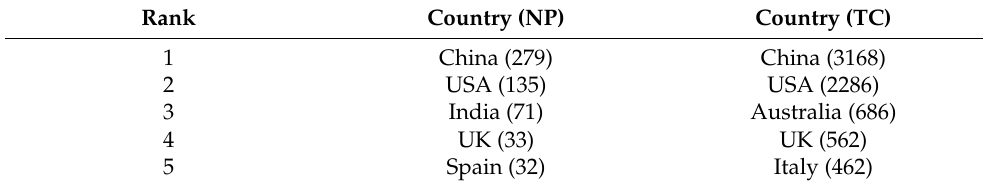
Table 5. Top 5 productive Countries.